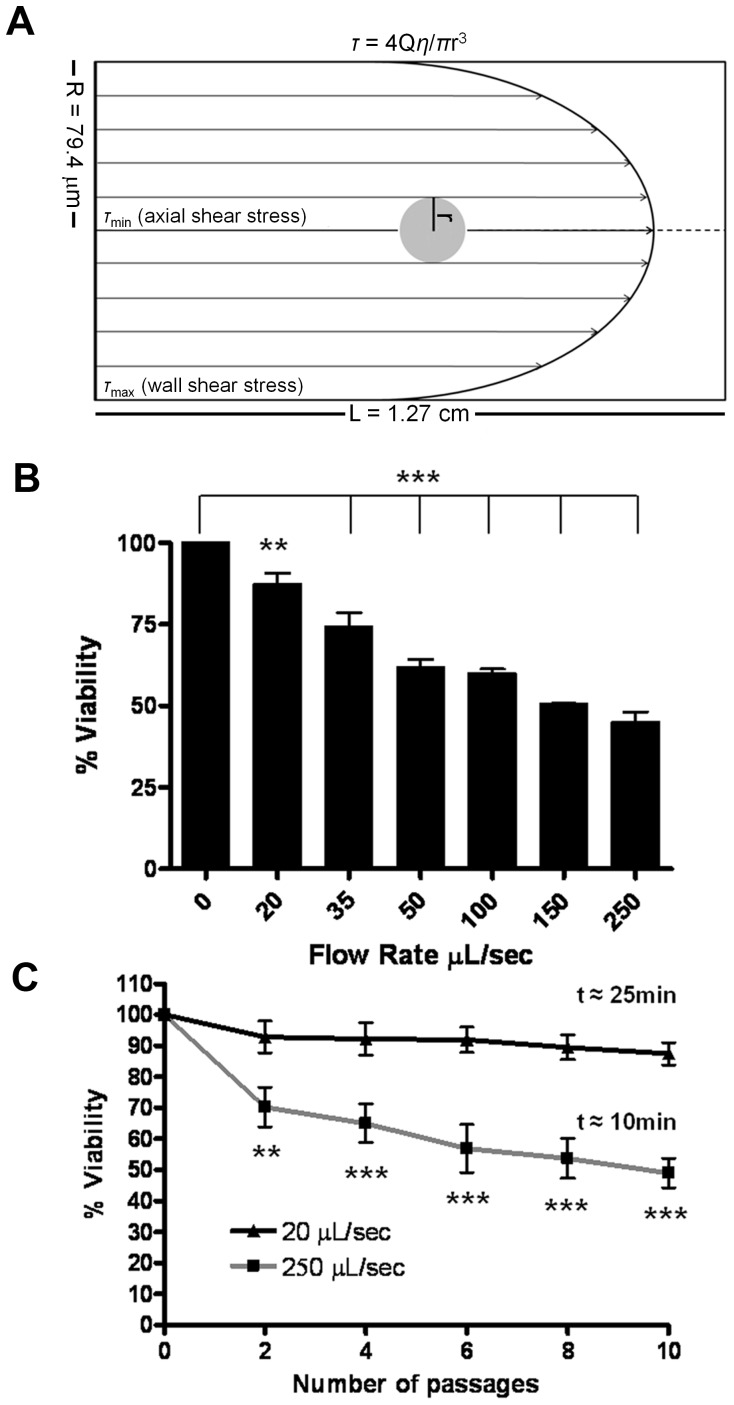
Fluid shear stress induces cell death in a magnitude-dependent manner.A. Scale illustration of a PC-3 cell subjected to FSS in this model. Note the gradient of increasing stress from the axis of flow to the wall of the needle. Suspensions of PC-3 cells were subjected to FSS at increasing flow rates and monitored for changes in viability. Survival is represented as percent viability of non-FSS treated cells which are held in suspension for the duration of the assay. B. Viability after ten passages at the indicated flow rate. (**, p<0.01; ***, p<0.001 vs. 0 control. One-way ANOVA, Bonferroni’s multiple comparison test; for each flow rate, n = 5 using syringe pump.) C. Survival over repeated passages at 20 and 250 µL/s. (**p<0.01, ***p<0.001 vs. 20 µL/s. Repeated measures ANOVA, Bonferroni’s multiple comparison test; for each flow rate n = 10 using syringe pump). The time taken to perform ten passages at each flow rate is indicated.